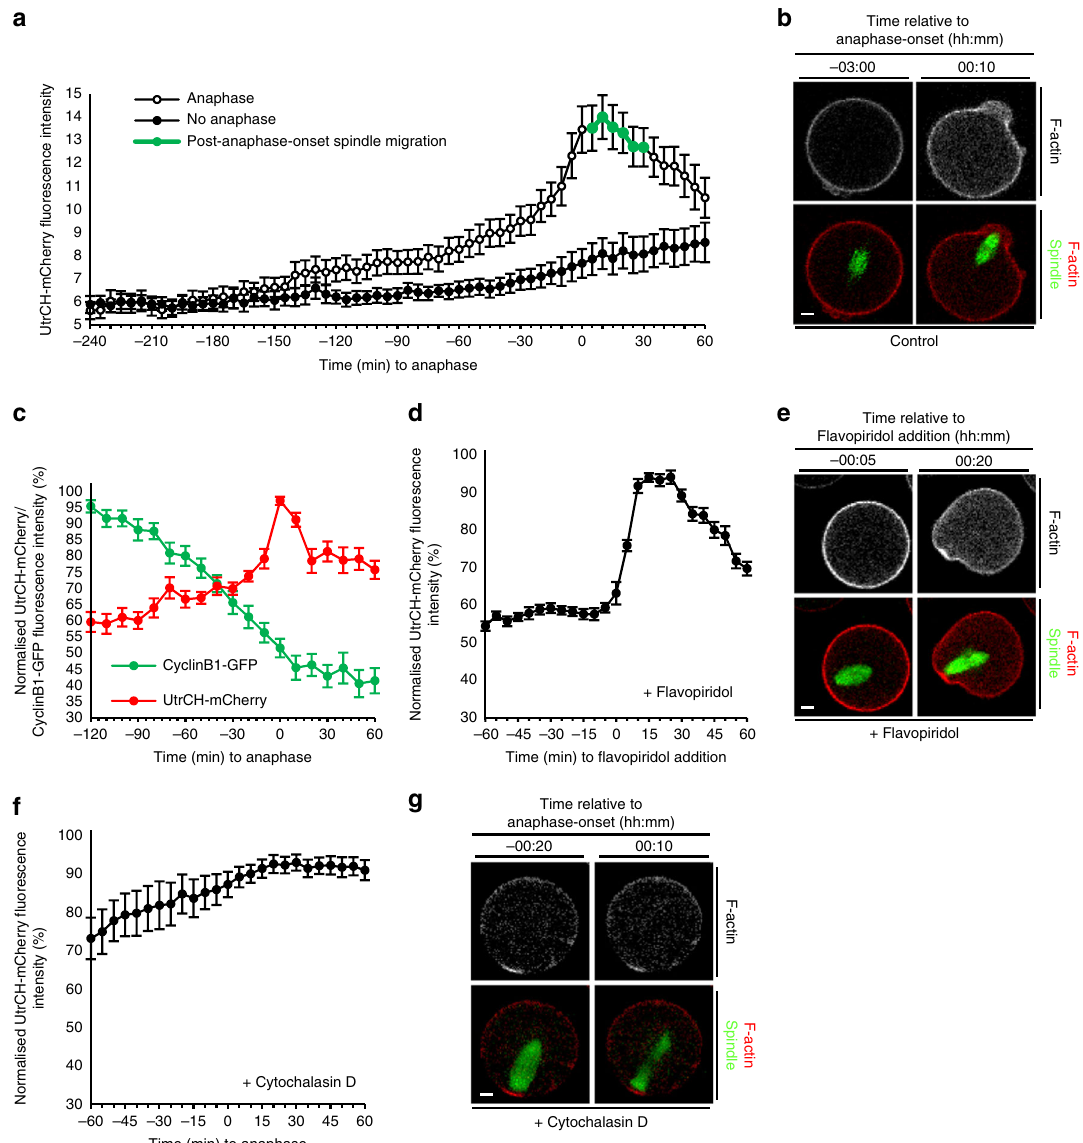
Fig. 4 Cdk1 inactivation induces increased F-actin required for spindle migration. a Cytoplasmic UtrCH-mCherry intensity in live oocytes relative to anaphase-onset. Shown is a representative replicate in which absolute intensity was determined for oocytes from the same experiment exposed to identical imaging parameters that either underwent anaphase ( n = 24) or not (no anaphase; n = 11). Note that spindle migration (green markers) occurs coincidently with the F-actin spike. b Increased cytoplasmic F-actin coincident with anaphase-onset (see Supplementary Movie 21). c UtrCH-mCherry and Cyclin B1-GFP fl uorescence relative to anaphase-onset in oocytes co-expressing both constructs ( n = 11). d , e UtrCH-mCherry fl uorescence changes following the addition of fl avopiridol at 4 h post-GVBD ( n = 15; see Supplementary Movie 22). f , g UtrCH-mCherry fl uorescence following cytochalasin D treatment from 6 h post-GVBD ( n = 11). Note the absence of migration and protrusion following anaphase-onset (see Supplementary Movie 23). Times in panels are hours:minutes relative to anaphase-onset ( b , g ) and to fl avopiridol addition ( e ), respectively. Scale bars, 10 µ m. All error bars are mean ± furrowing. We imaged the spindle and the cortex and found that acute furrowing occurred at the base of the protrusion, midway along the length of the spindle (Supplementary Fig. 9 and Sup- plementary Movie 25), con fi rming that the midzone at the end of anaphase spindle migration de fi nes the site of furrowing. Since post-anaphase-onset spindle migration determines mid- zone position and hence the site of furrowing, the extent of migration could be critical for determining the degree of asymmetry. To better interrogate the effects of post-anaphase- onset migration, we sought to exaggerate the distance available for this phase of migration by inhibiting pre-anaphase migration. Our previous data indicated that, to leave post-anaphase-onset